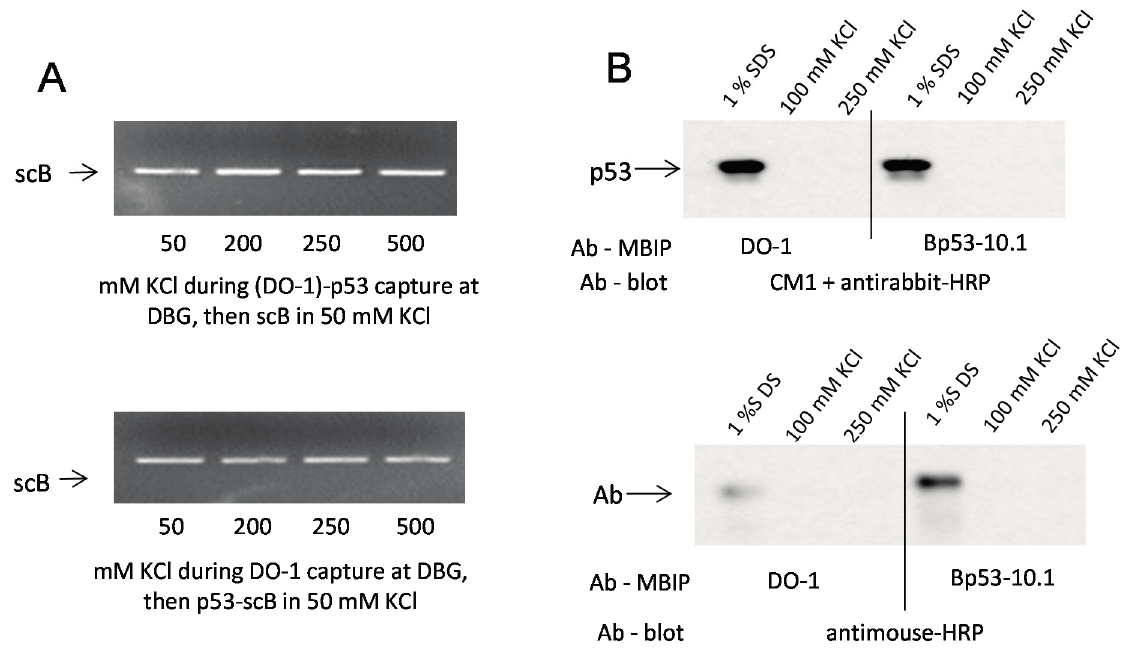
Figure 3. Effects of KCl concentration on (protein G)-Ab or Ab-p53 bonds. ( A ) Top : (DO-1)-p53 immune complex was formed in solution and captured at the MBG from binding buffer containing the given KCl concentrations, followed by binding of scB DNA from 50 mM KCl; Bottom : DO-1 Ab was immobilized at the MBG from the given KCl concentration; p53-scB DNA complex was formed in solution containing 50 mM KCl and from the same medium it was captured at the (DO-1)-modified MBG. In both cases, the beads were then washed in 50 mM KCl, DNA was released by SDS treatment and analyzed by agarose gel electrophoresis; and ( B ) Top : Western blot analysis of the p53 protein after treatment of MBG with immunoprecipitated (DO-1)-p53 or (B-10)-p53 complexes with 1% SDS, 100 or 250 mM KCl. The samples were resolved by 12.5% SDS-polyacrylamide electrophoresis. Proteins from the gels were transfered onto nitrocellulose membranes. The p53 protein was detected using rabbit polyclonal CM1 antiserum and antirabbit-HRP conjugate; Bottom : as above but antimouse-HRP conjugate was used to detect the anti-p53